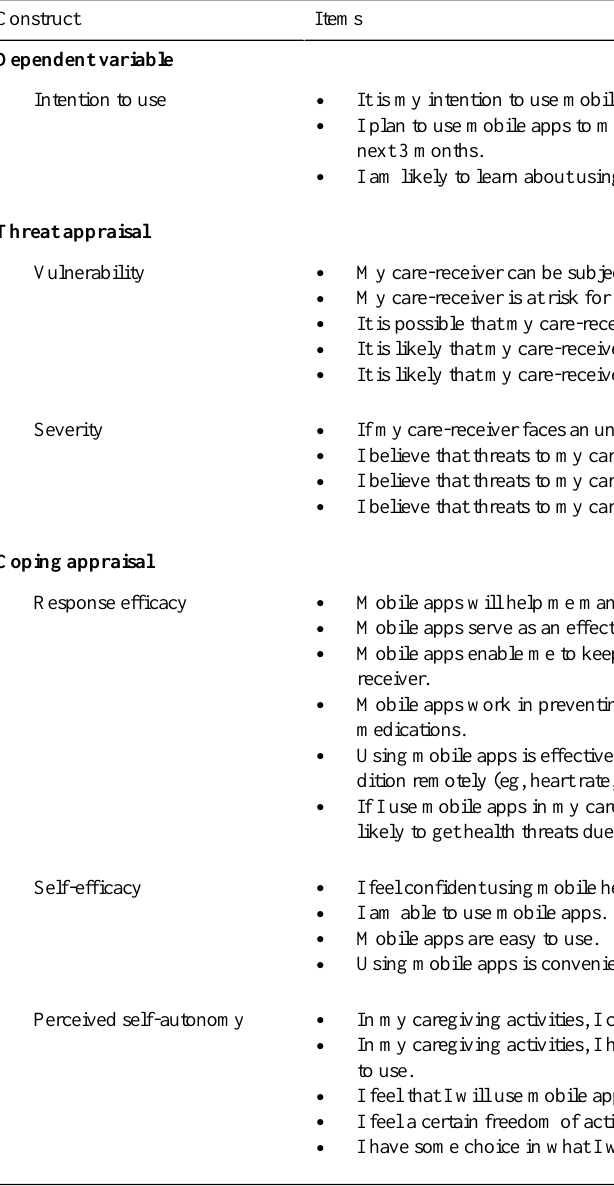
Table 2. Instrument